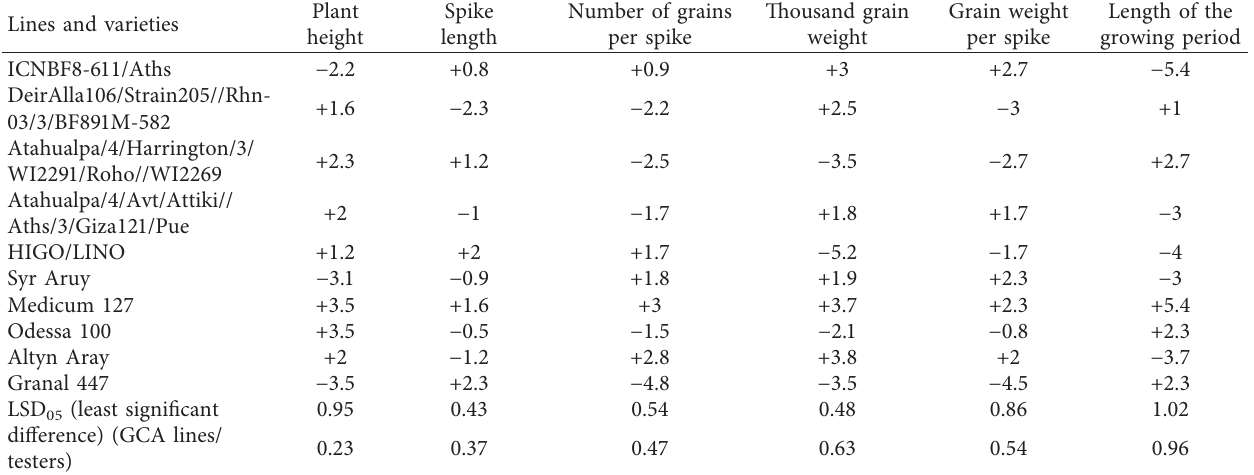
Table 6: Estimates of the effects of general combining ability ( 􏽢 gi and 􏽢 gj ), 2017–2019. Lines and